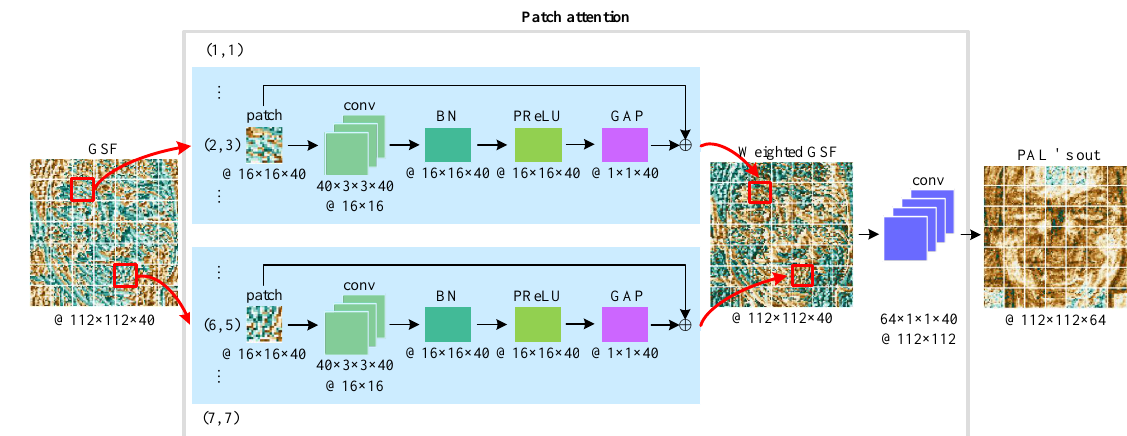
Figure 2. An illustration of the proposed patch attention model. GSF—Gabor Surface Feature; conv—Convolution operation; BN—Batch Normalization; PReLU—Parametric Rectified Linear Unit; GAP—Global Average Pooling.